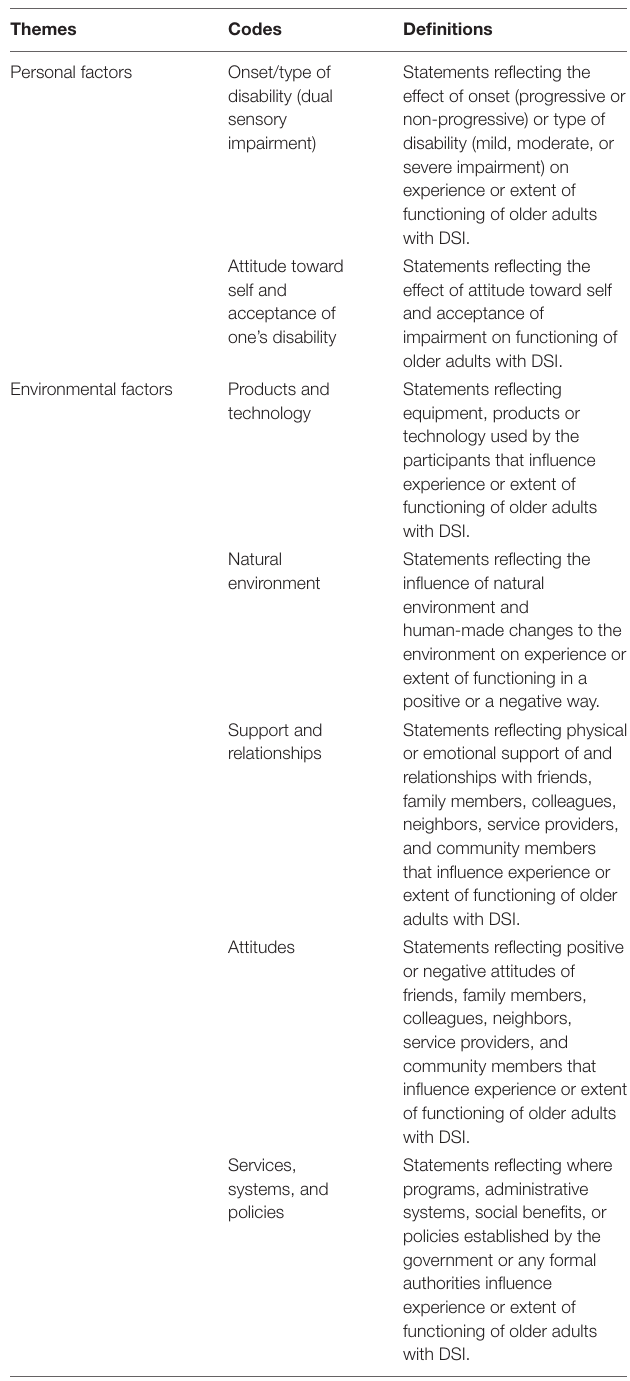
TABLE 1 | Codebook on personal and environmental